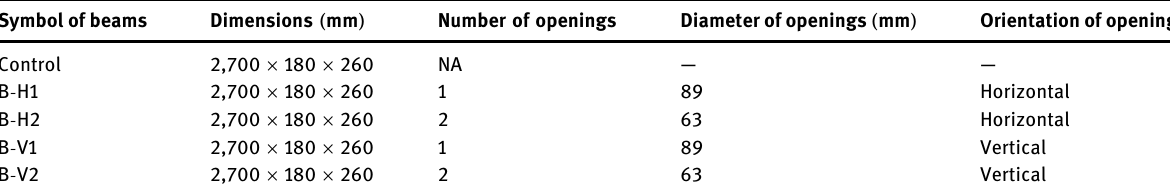
Table 1: Full description of the proposed beams used in the analysis Symbol of beams